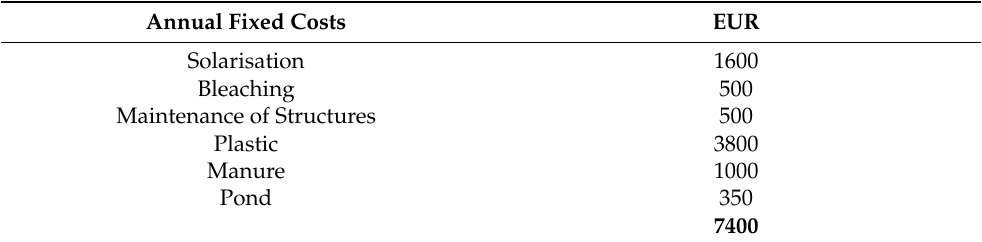
Table 4. Annual Fixed Costs for a Greenhouse